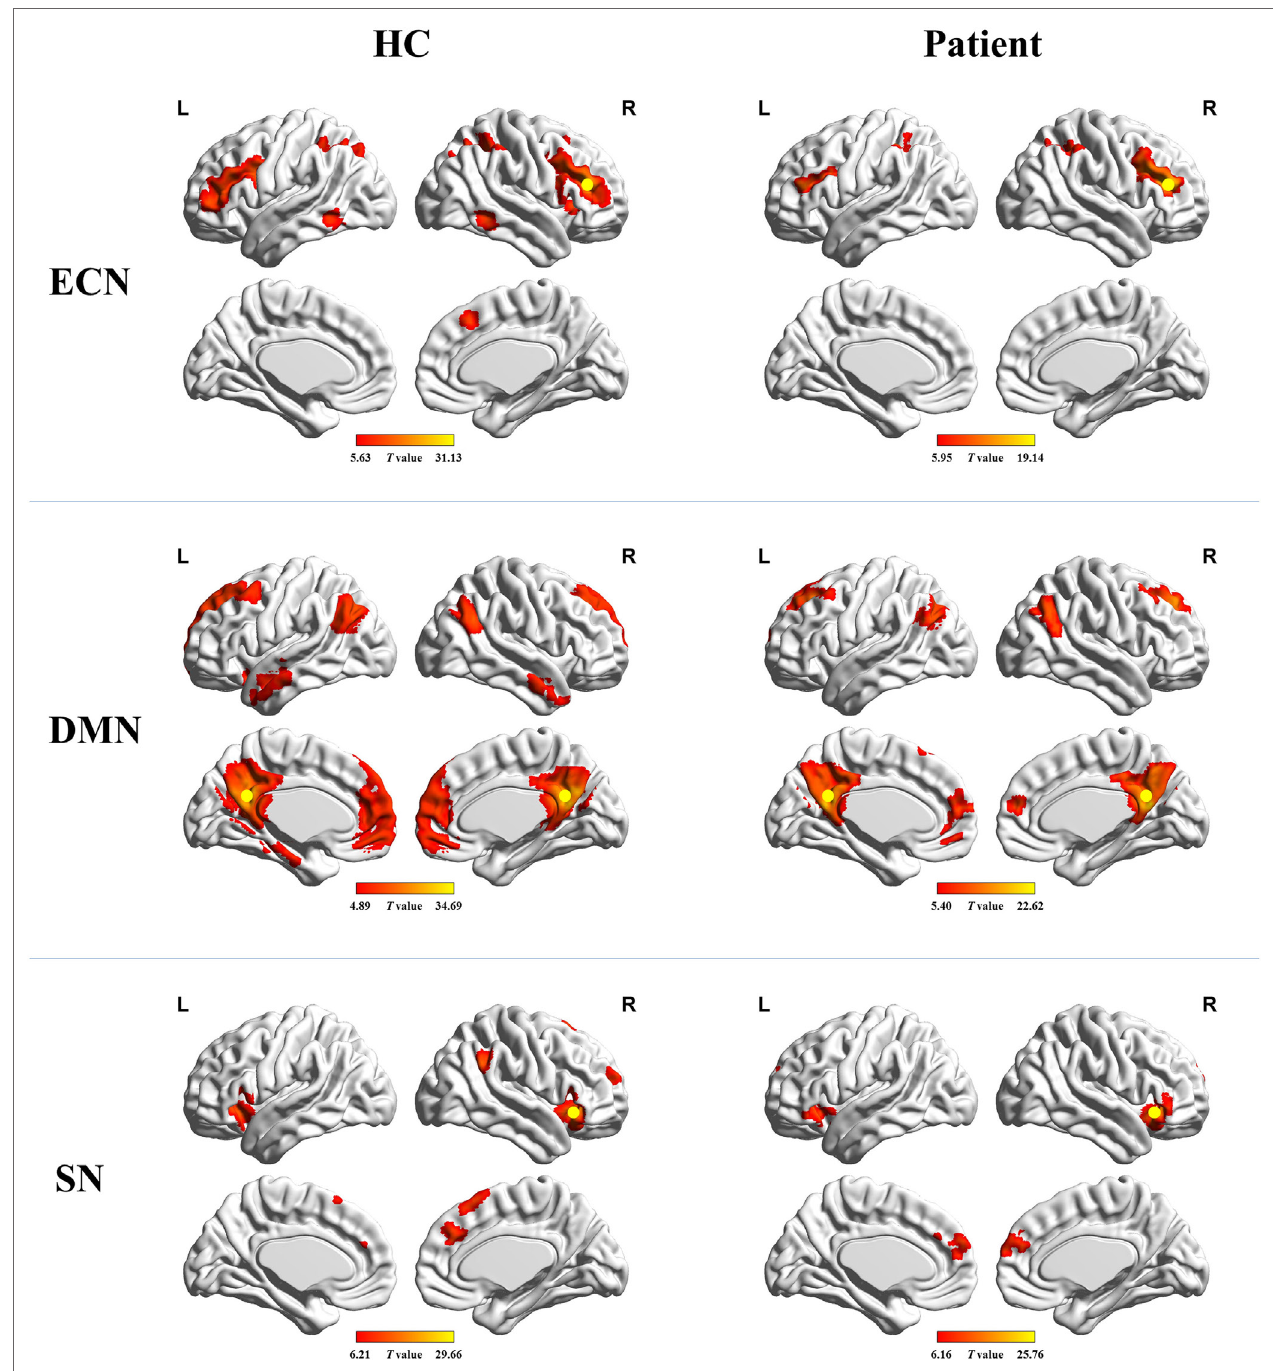
FigUre 1 | Functional connectivity maps for healthy controls and cirrhotic patients. Yellow circles denote locations of the seed regions used to define each network. Abbreviations: ECN, executive control network; DMN, default mode network; SN, salience network. A threshold of P < 0.001 (false discovery rate corrected) was set to identify significance